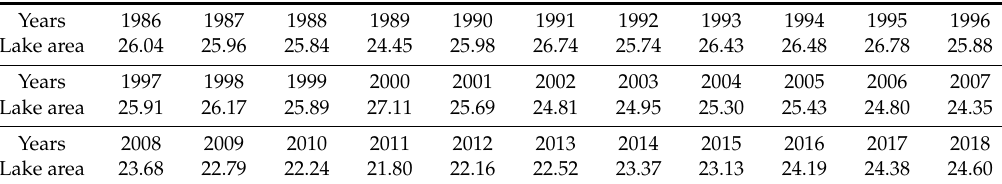
Table 1. Water surface area of the Ugii Nuur Lake, km 2 .